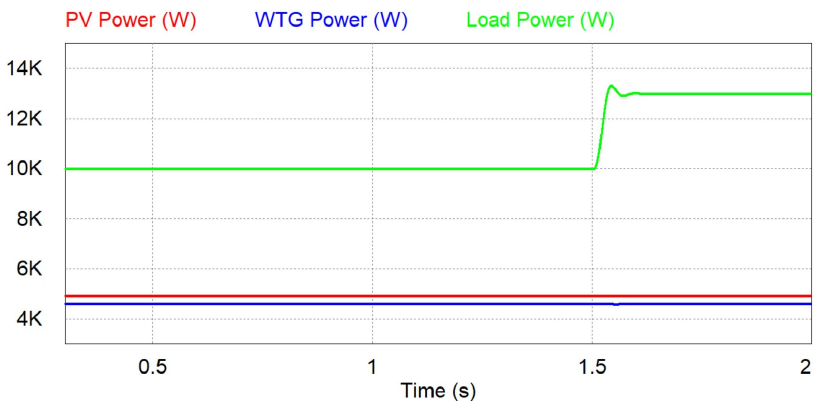
Figure 17. The power of PV, WTG, and load—Case 3.